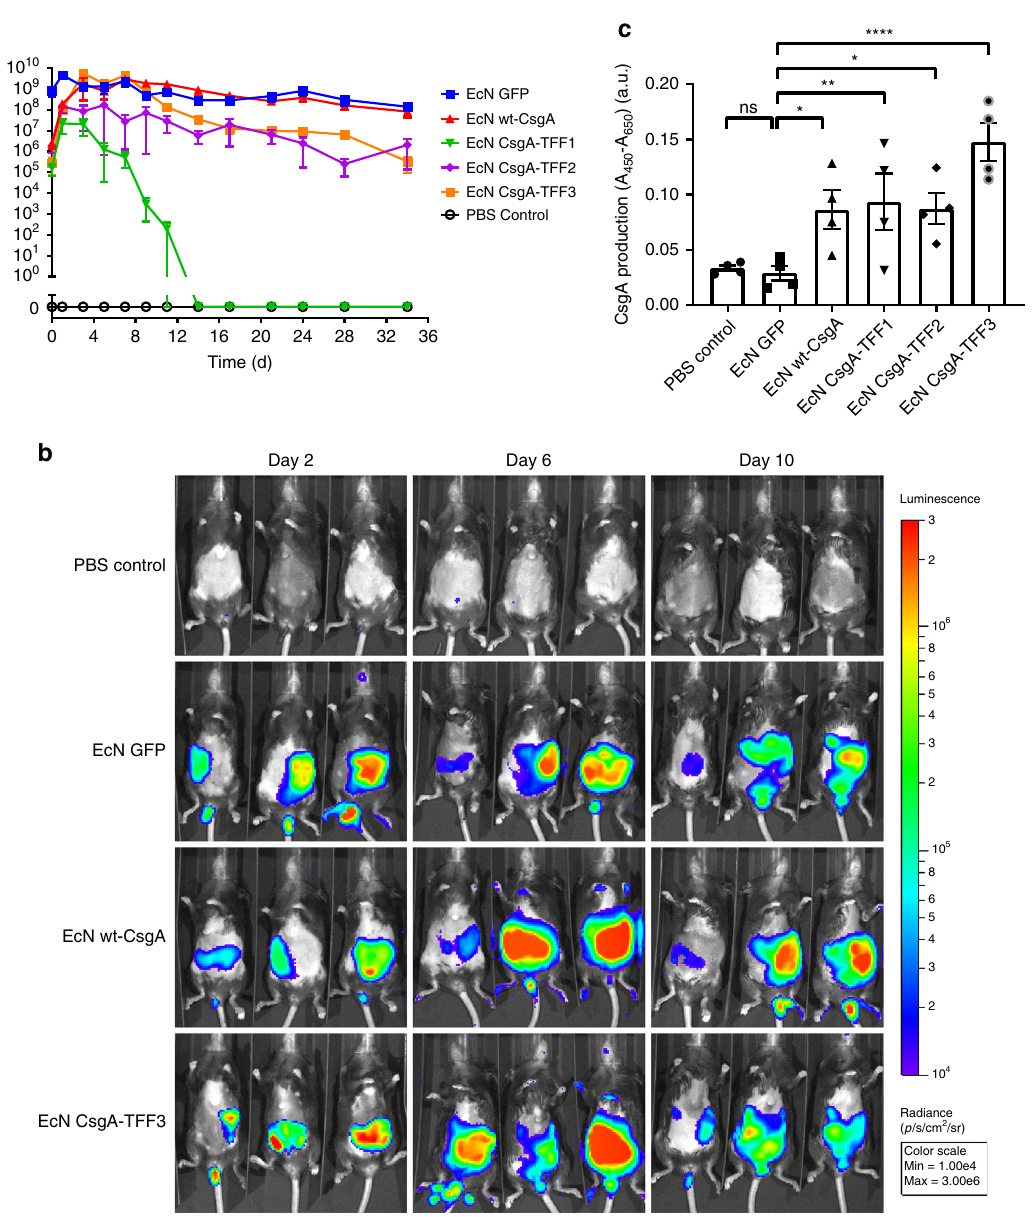
Fig. 4 Residence time of engineered EcN in the mouse gut and in vivo curli expression. a In vivo residence time for EcN variants, as measured by CFU counting from fecal samples (Blue = EcN GFP, Red = EcN wt-CsgA, Green = EcN CsgA-TFF1, Pink = EcN CsgA-TFF2, Orange = EcN CsgA-TFF3, Black = PBS Control). b IVIS images of mice that received either PBS or luminescent EcN variants at various time points post-inoculation. c Relative CsgA production from fecal sample analysis of mice 5 days post-inoculation, as measured by ELISA. Data are represented as mean ± SEM. (ns) p > 0.05, * p ≤ 0.05, ** p ≤ 0.01, *** p ≤ 0.001, **** p ≤ 0.0001, one-way ANOVA followed by Fischer ʼ s Least Signi fi cant Difference (LSD) multiple comparison. Source data are provided as a Source Data fi the course of the experiment, similar to that of EcN transformed an EcN strain with a genomically integrated luminescence operon with a pBbB8k plasmid encoding for green fl uorescent protein ( luxABCDE ) to facilitate in vivo tracking 37,38 . After transformation of this EcN strain with the panel of plasmids encoding the synthetic curli operons, the strains were administered to healthy mice engineered EcN any more than recombinant production of any (C57BL/6NCrl) via oral gavage, concurrent with drinking water containing kanamycin and L -( + )-arabinose in order to maintain the plasmids and induce curli expression. A single dose of 10 8 colony-forming units (CFU) led to persistent colonization experiment to ~10 6 – 10 7 CFU, suggesting that production of the (>32 days) of the mouse GI tracts for all but one of the curli CsgA-TFF fusions was stressful enough to compromise the colo- producing strains (EcN wt-CsgA, EcN CsgA-TFF2, and EcN CsgA- nization ability of EcN in the stringent environment of the mouse TFF3), as measured by CFU counted from fecal samples. Notably, gut. We speculate that this may be due to the large size of the TFF fusion domains 39 , in addition to their propensity to form internal